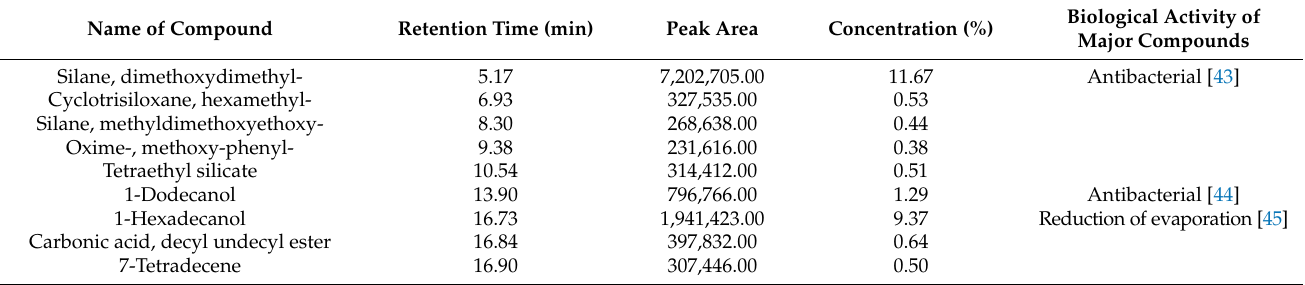
Table 7. Substances detected by GC/MS analysis and biological activity of the major compounds in the leaf water extract of Quercus aegilops